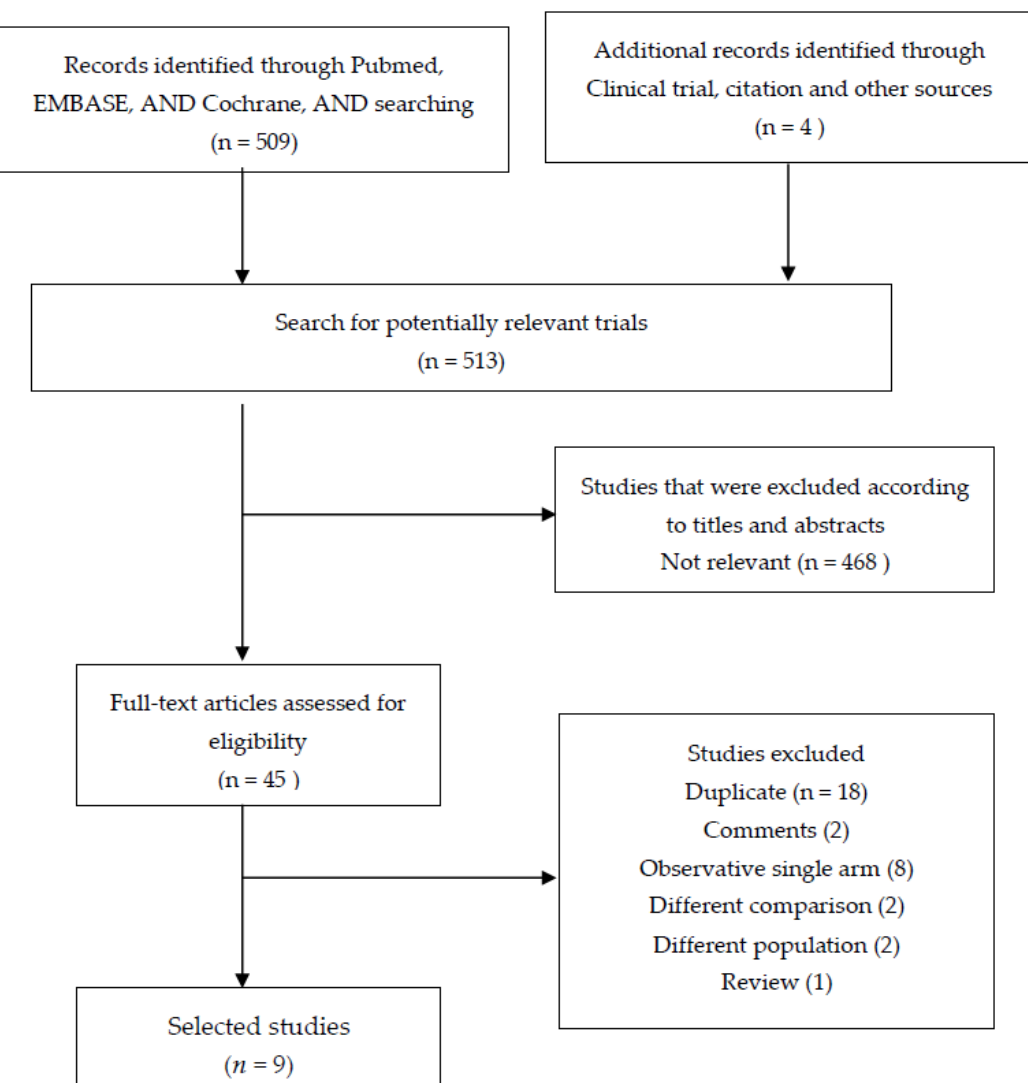
Figure 1. Flow diagram of the article s’ selection process .